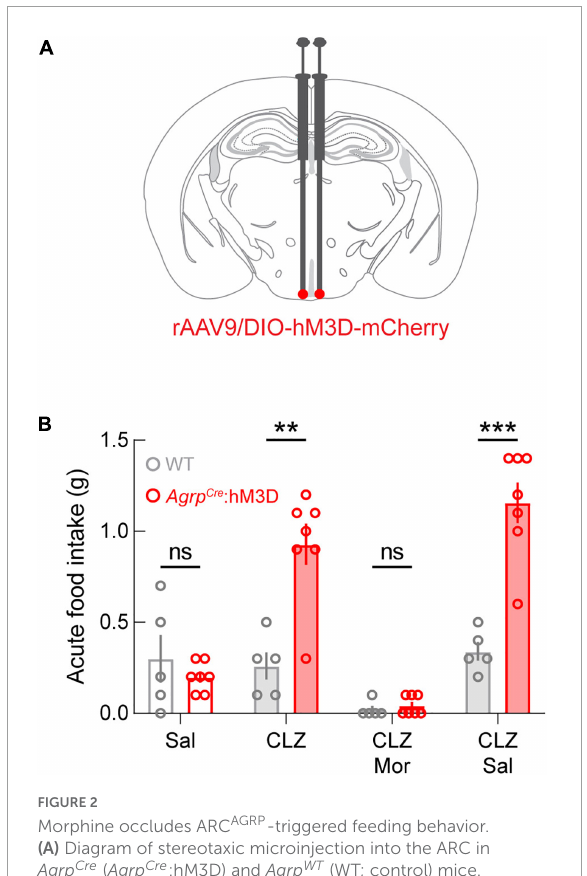
FIGURE2 Morphine occludes ARC AGRP -triggered feeding behavior. (A) Diagram of stereotaxic microinjection into the ARC in Agrp Cre ( Agrp Cre :hM3D) and Agrp WT (WT; control) mice. (B) While there are no differences in the feeding behavior of animals after saline administration, between groups differences are evident following clozapine (CLZ) and CLZ + saline (Sal) administration. ARC AGRP -triggered feeding behavior is completely abolished by morphine (Mor) administration. See Supplementary Table 1 for details on statistical analyses. ** p < 0.01, *** p < 0.001.